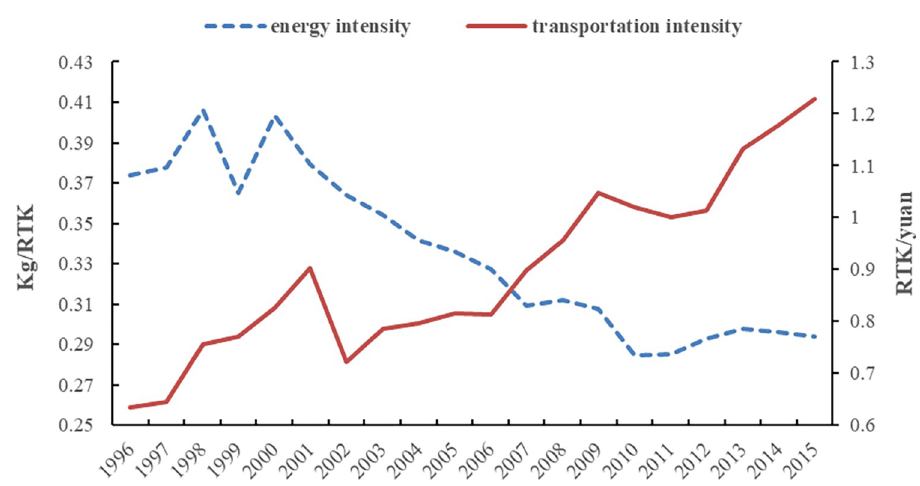
Fig 5. Changes in energy intensity and transportation intensity,